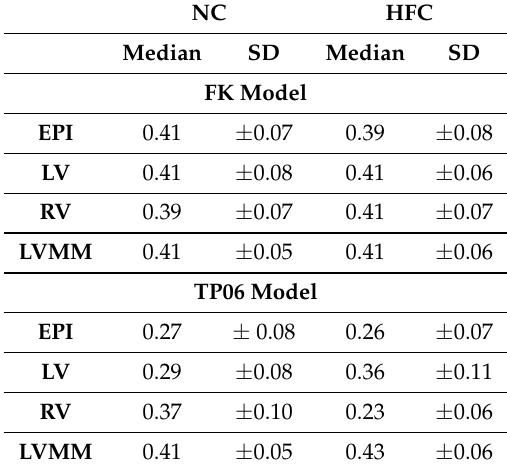
Table 2. Medians and standard deviations for FK and TP06 model, corresponding to Figure 4 (CL =